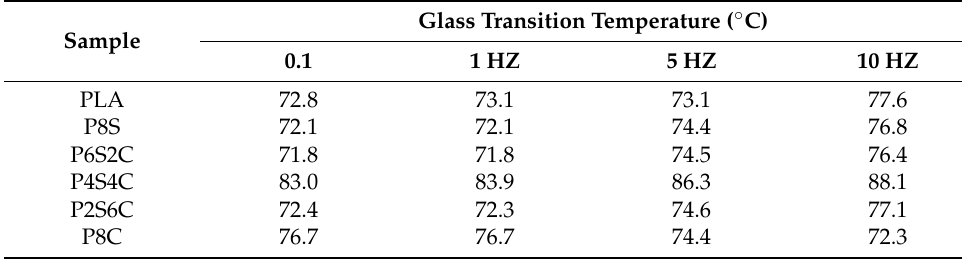
Figure 5. The effect of frequency on DMA loss factor curves of the ( a ) PLA, ( b ) P8S, ( c ) P6S2C, ( d ) P4S4C, ( e ) P2S6C and ( f ) P8C biocomposite. Table 3. Glass transition temperature values with frequency